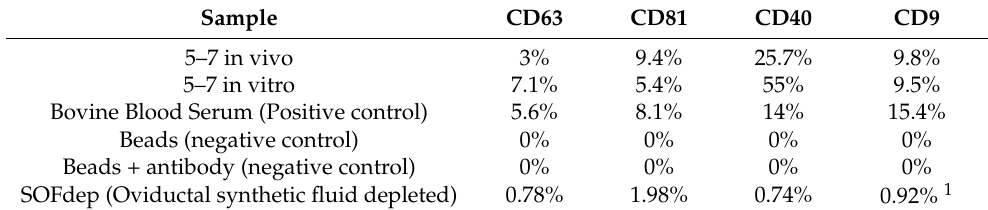
1 EVs-IVV 5–7 and EVs-IVP 5–7: EVs released during blastulation (Days 5–7 of development) by bovine embryos produced in vivo or in vitro, respectively. SOFdep: Oviductal synthetic fluid depleted of EVs. Culture medium without contact with embryos was used as negative